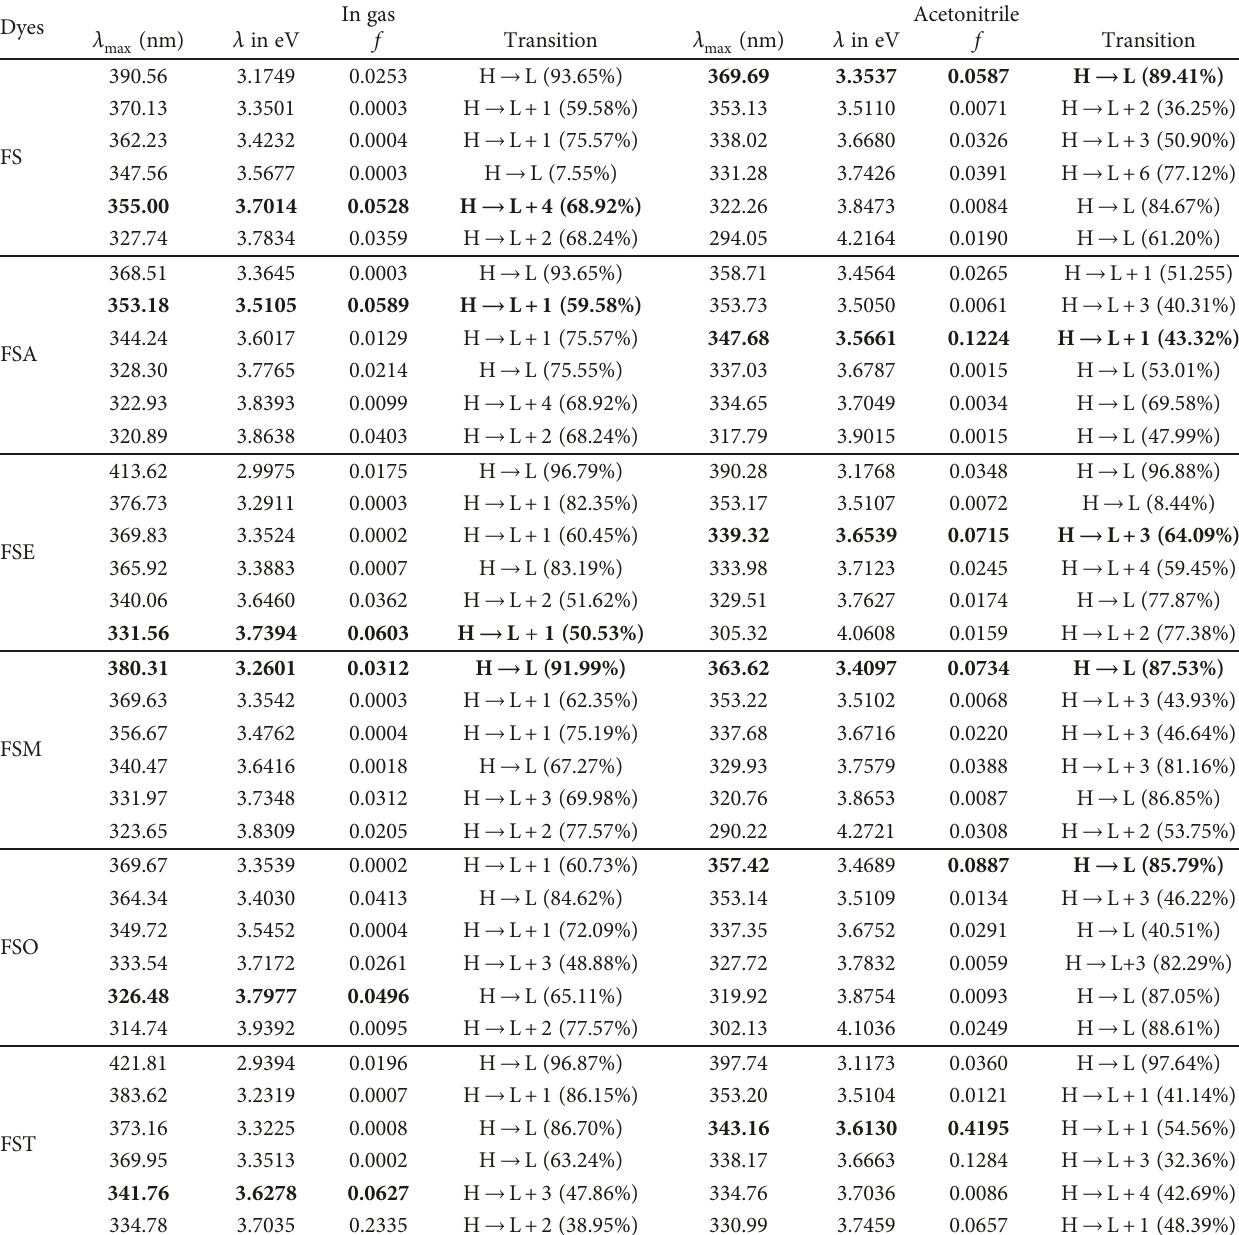
Table 3: The absorption properties of studied dye derivatives in a gas phase and acetonitrile. In Dyes